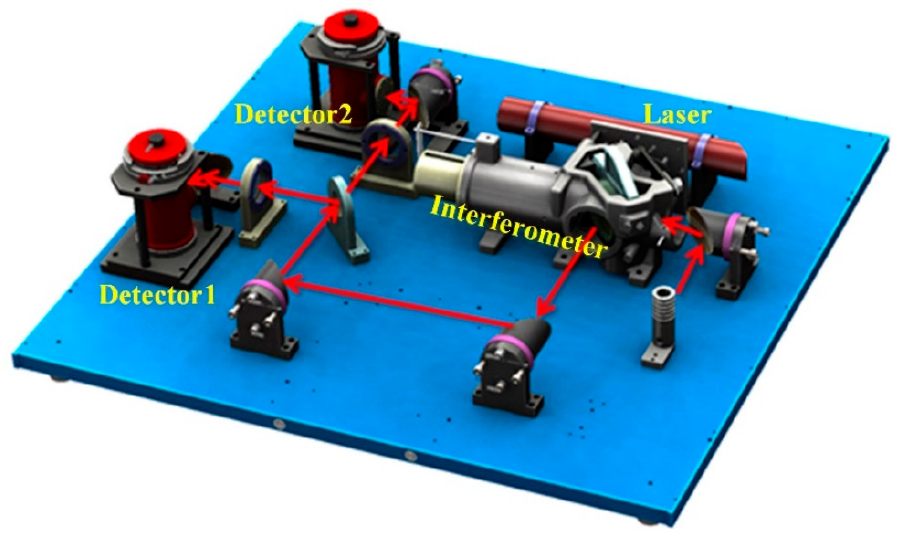
Figure 3. Optical path layout of HRFTS system.